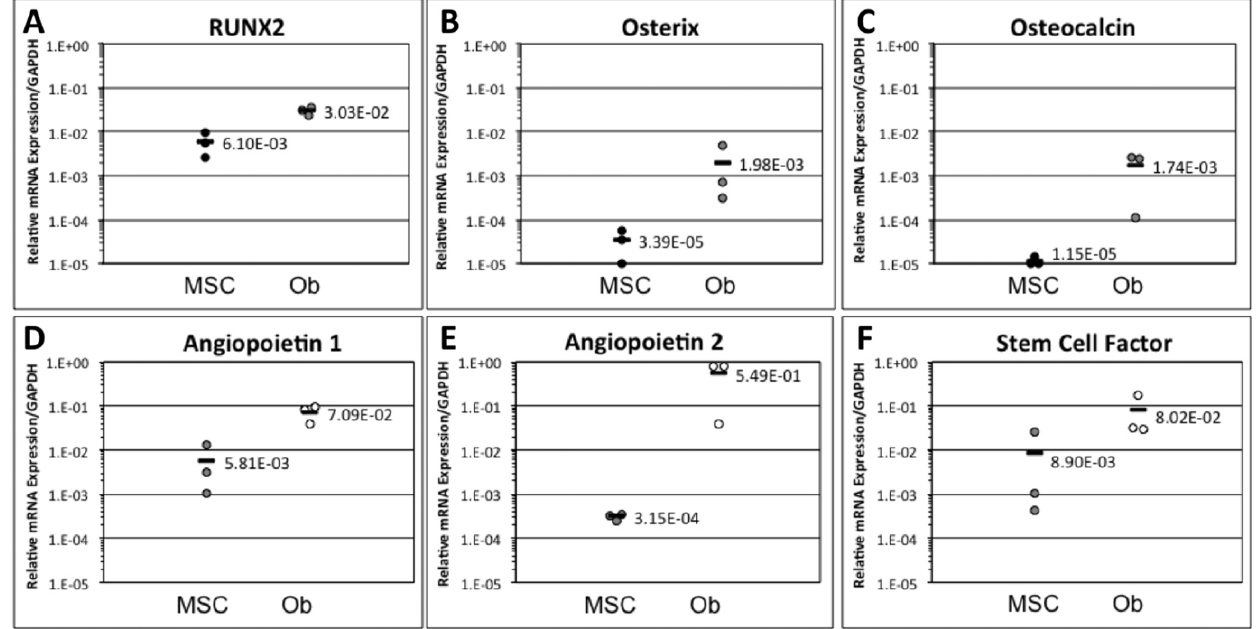
Figure 1. Comparison of mesenchymal stromal cell (MSC) and osteoblast monolayers for bone-related and haematopoietic stem cell (HSC) niche markers. Differentiation into osteoblasts was shown to increase the expression of ( A ) RUNX2, ( B ) osterix and ( C ) osteocalcin when compared to undifferentiated MSCs. MSCs or MSC-derived osteoblasts were examined for expression of HSC niche genes including ( D ) angiopoietin-1, ( E ) angiopoietin-2, ( F ) stem cell factor, ( G ) jagged-1 and ( H ) stromal cell-derived factor-1 (CXCL12). Data is shown as mean ± SD with each point representing independent MSC and MSC-derived osteoblast cultures from distinct